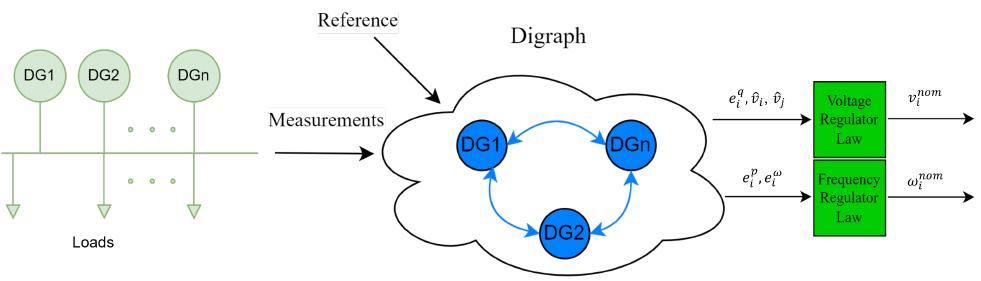
Figure 2. Diagram of the implemented secondary consensus-based